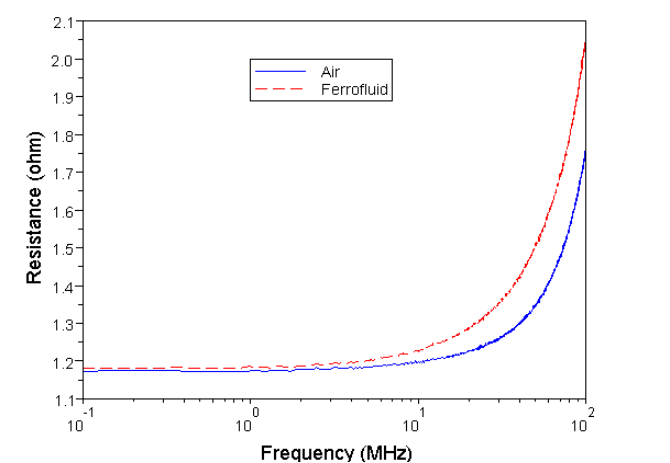
Figure 11. The resistance of coils with the air core and magnetic core of 1 M Fe O 3 4